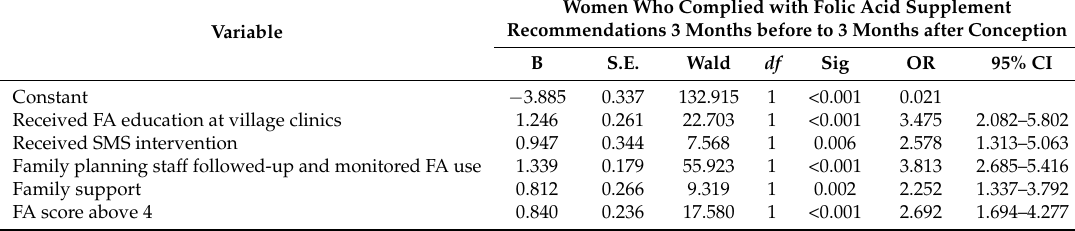
Table 4. Factors associated with compliance with folic acid supplement use from 3 months before to 3 months after conception among rural women according to multivariate logistic